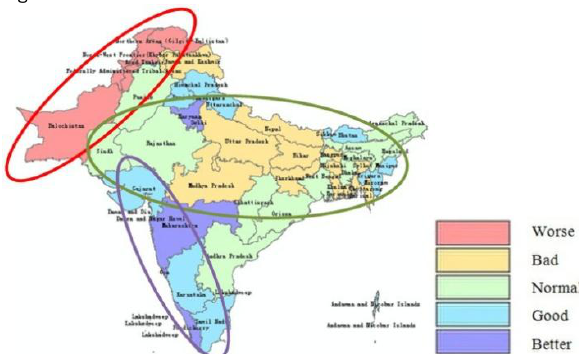
Figure 1. The socio-economic unit division of South Asia From figure 1, we can see that south Asia can be roughly divided into three units on the socio-economic factor, the worse northwest region, the general central region and the better southwestern region.